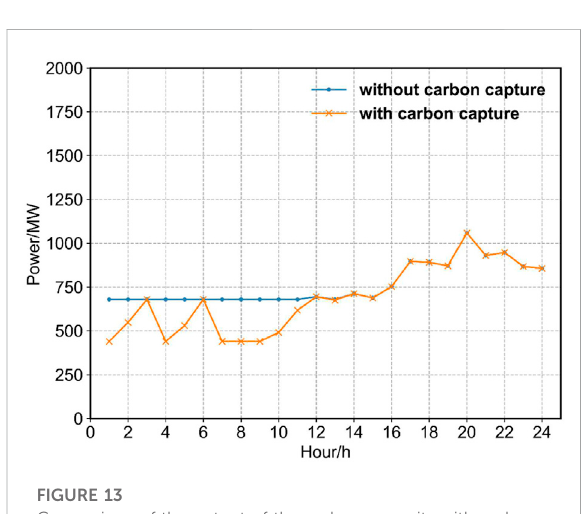
FIGURE 13 Comparison of the output of thermal power units with and without carbon capture